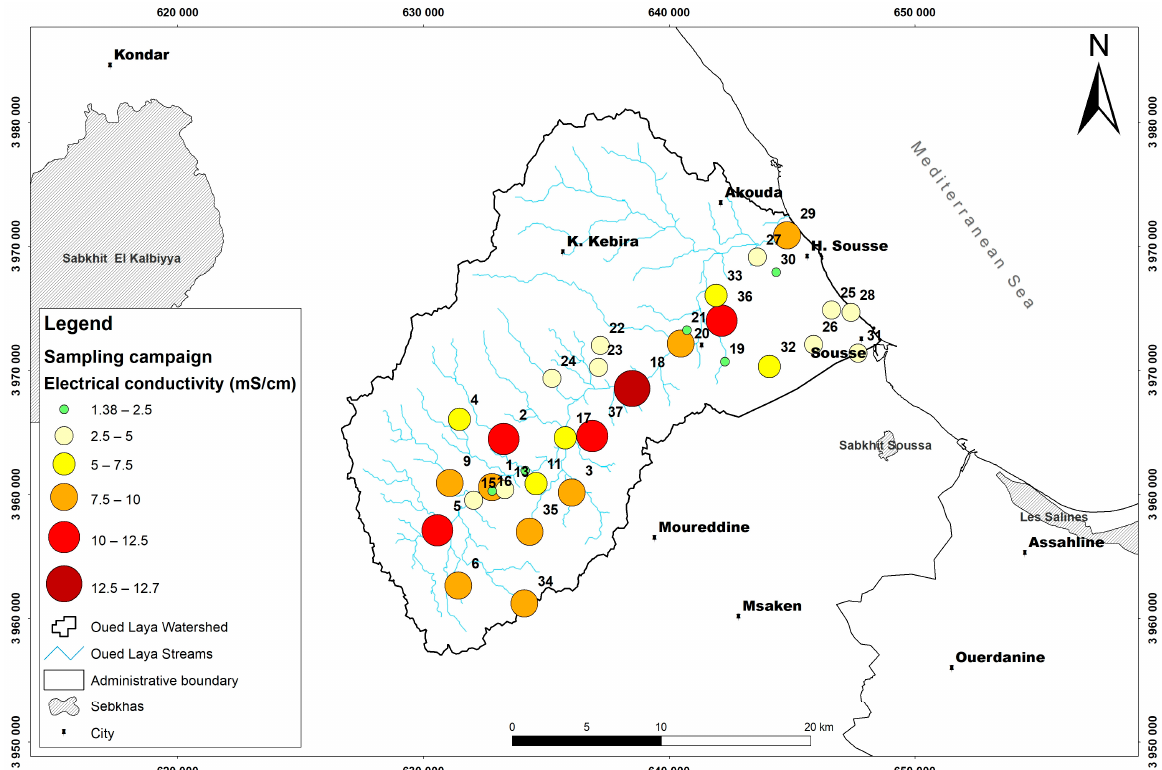
Figure 5. Electrical conductivity distribution map of the studied area.